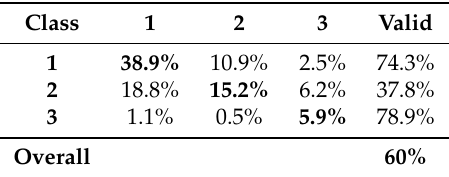
Table 5. Results from the test part of the dataset from the CNN for vehicle classification reduced to 3 classes. Final results for each class on the main diagonal in confusion matrix (highlighted as bold) are